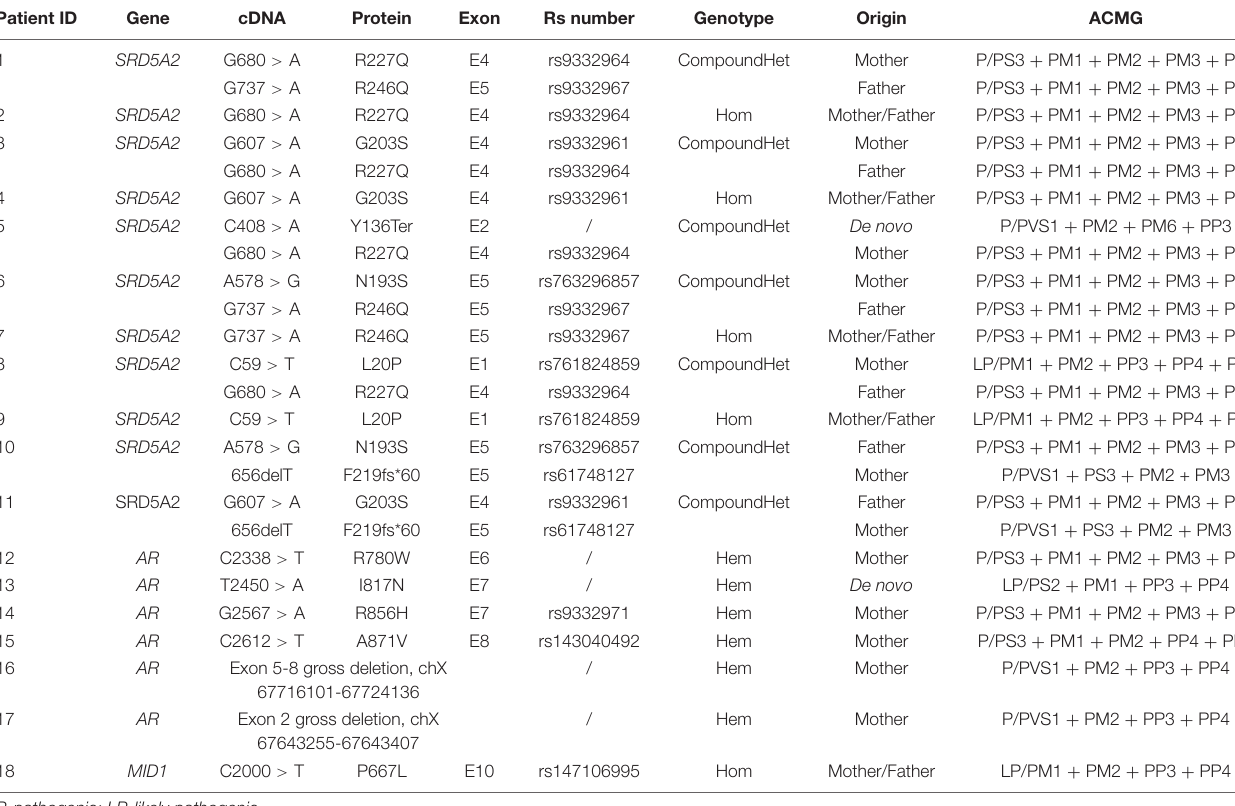
TABLE 2 | Genotype hypospadias patients with candidate gene abnormities. Patient ID